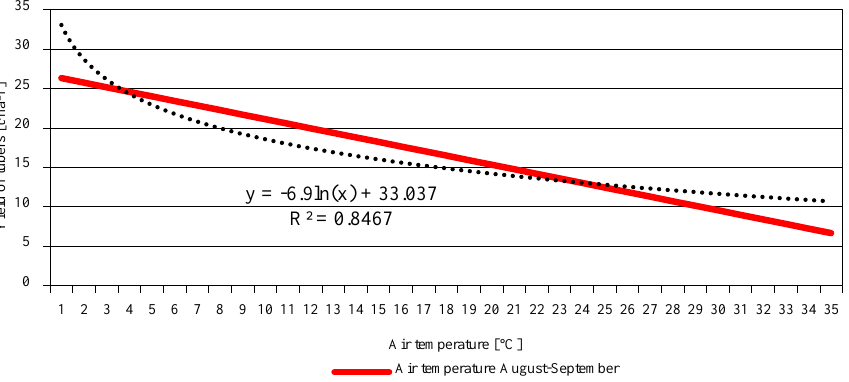
Figure 6. Partial dependence of tuber yield on air temperature in the June – July period. The results of the regression analysis of the yield with air temperature in the second part of the growing season (August – September) are described by the formula in Figure 7. As a result of the air temperature increase in this period of time, there was a systematic decrease in yield value. The value of the coefficient of determination, amounting to 84.67%, makes the equation highly reliable [19].